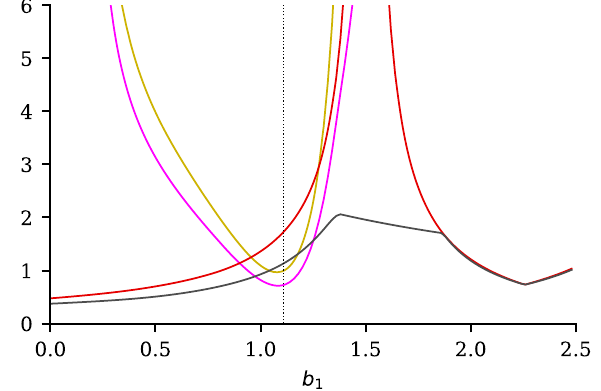
FIG. 10. G objective for the standard sextupole harmonics ( P ¼ 1 : yellow) and extended harmonics ( P ¼ 2 : magenta) as well as max j m j ( P ¼ 1 : red, P ¼ 2 : dark gray) in dependence of the dipole coefficient b 1 . The example value of b 1 is marked with a dashed